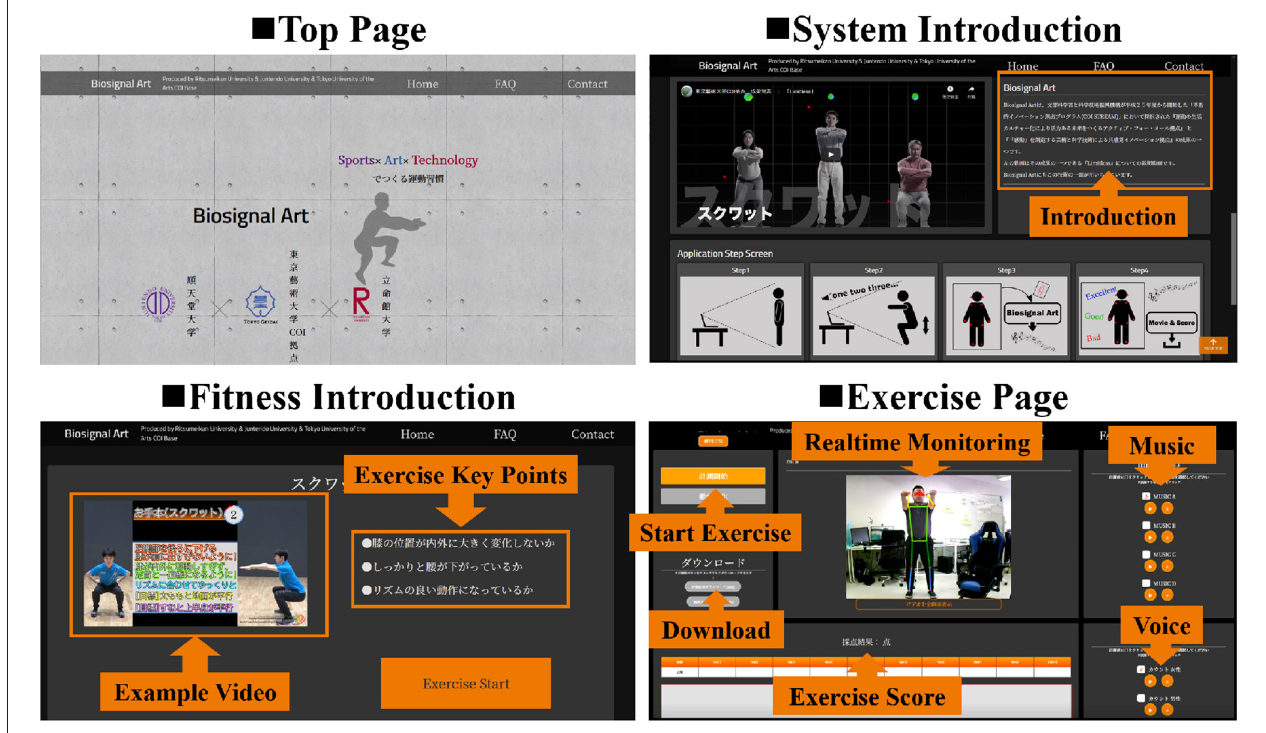
FIGURE 2 | Samples of system